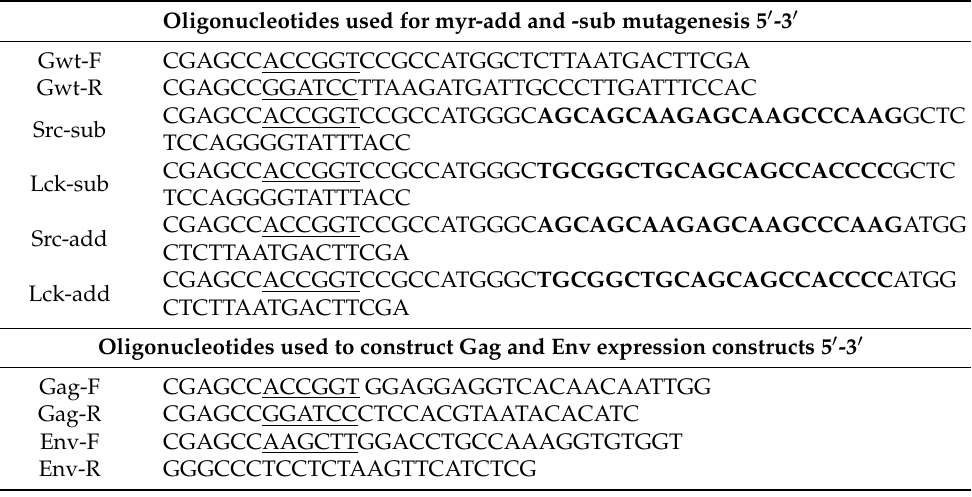
Table 1. PCR primers used for bovine foamy virus (BFV) wt and myr-Gag and Env expression